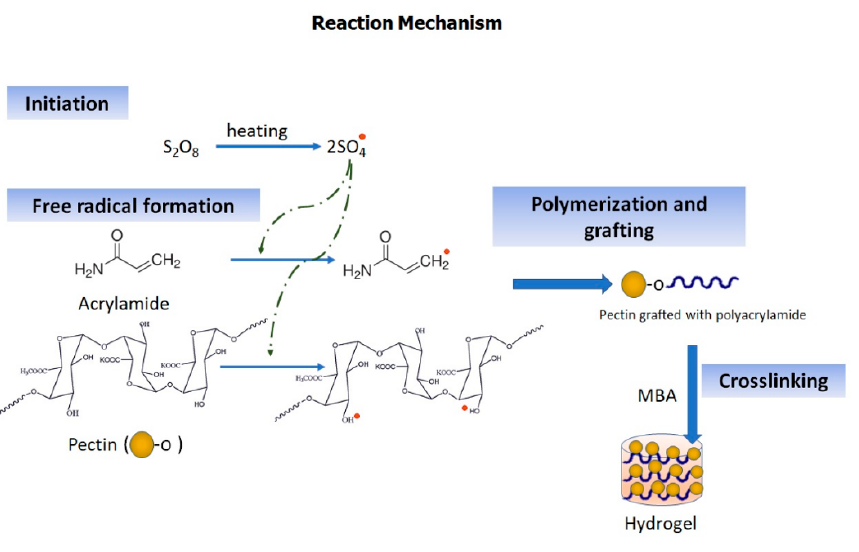
Figure 1. Reaction mechanism of hydrogel. Table 1. Gel fraction of PC/polyacrylamide hydrogel based on different amounts of acrylamide and PC with a constant ratio of MBA/KPS. Formulation Code